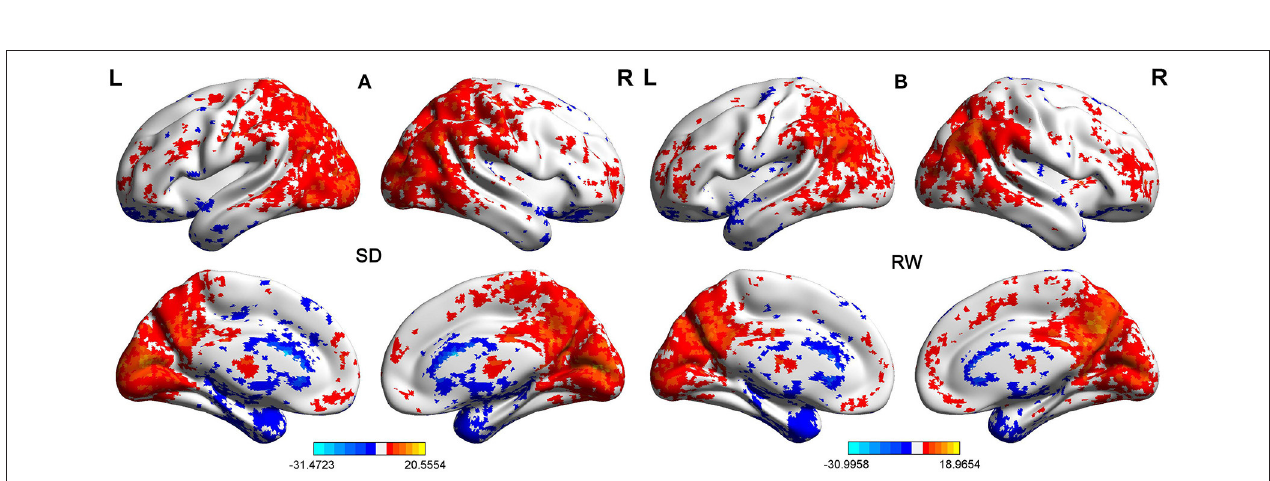
FIGURE 1 | Behavioral findings of ANT. The accuracy rate and reaction time of RW group (A) and SD group (B) , respectively. Data is presented as mean ± standard error. ANT, Attention network test; SD, Sleep deprivation; RW, Rested wakefulness.